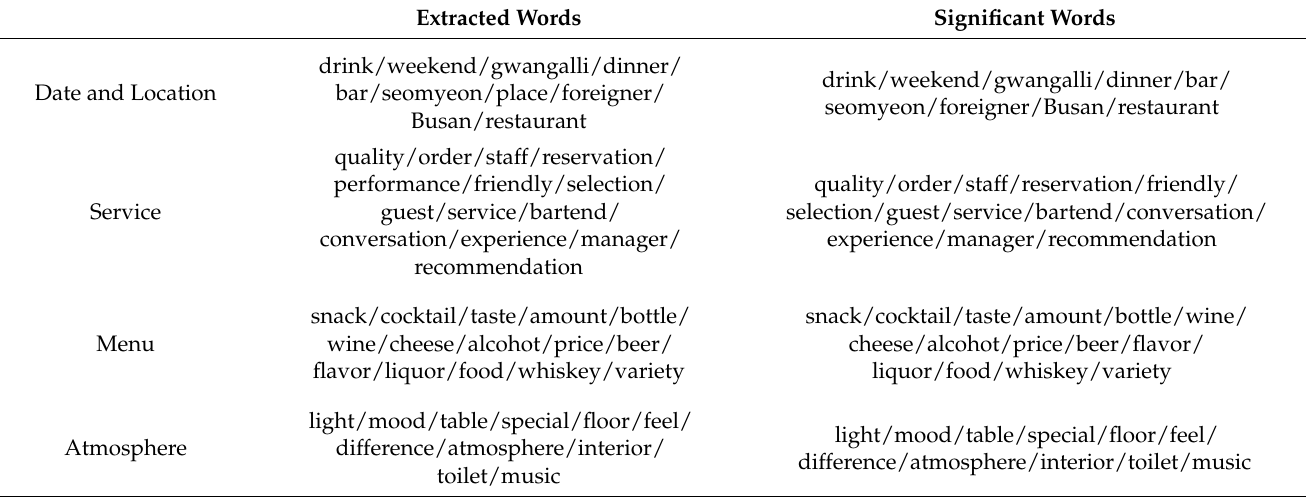
Table 4. Result of CONCOR